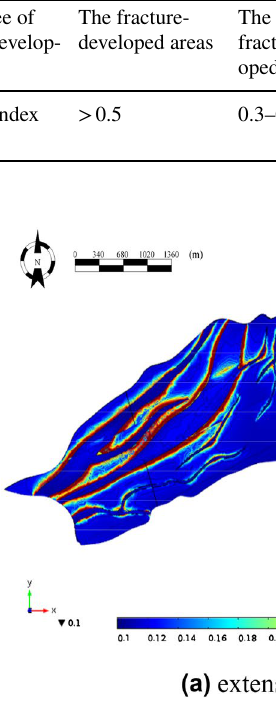
Fig. 3 The development situation of natural fracture of II oil